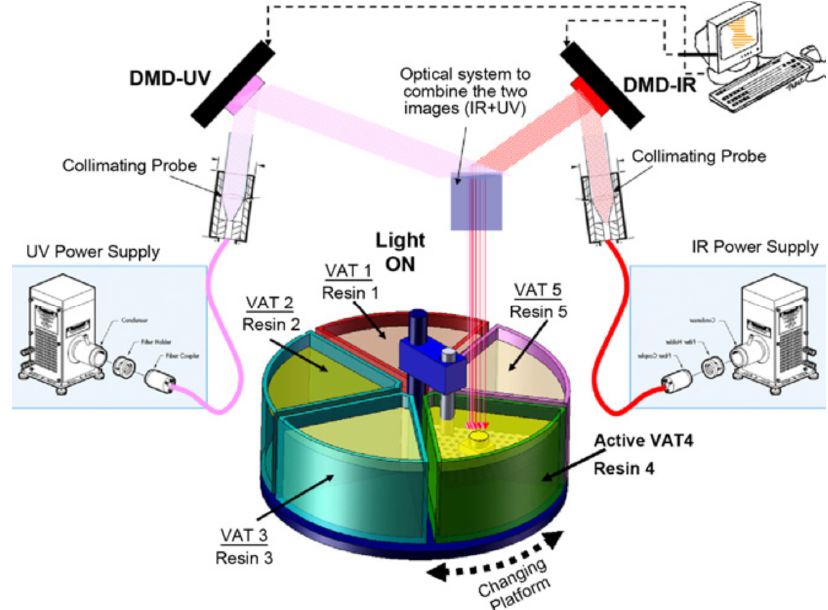
Figure 5. The micro stereo-thermal-lithographic process: multivat system. Reproduced from [46] with permission from Elsevier.